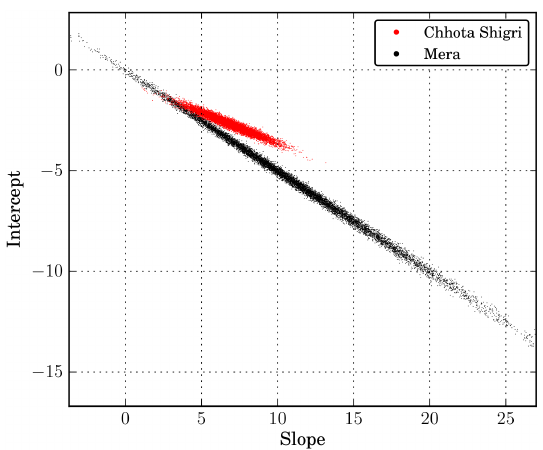
Figure 11. Regression parameters obtained from the Monte Carlo simulation ( N = 10000). Every data point represents a slope- intercept couple obtained as the best fit of B a as a function of